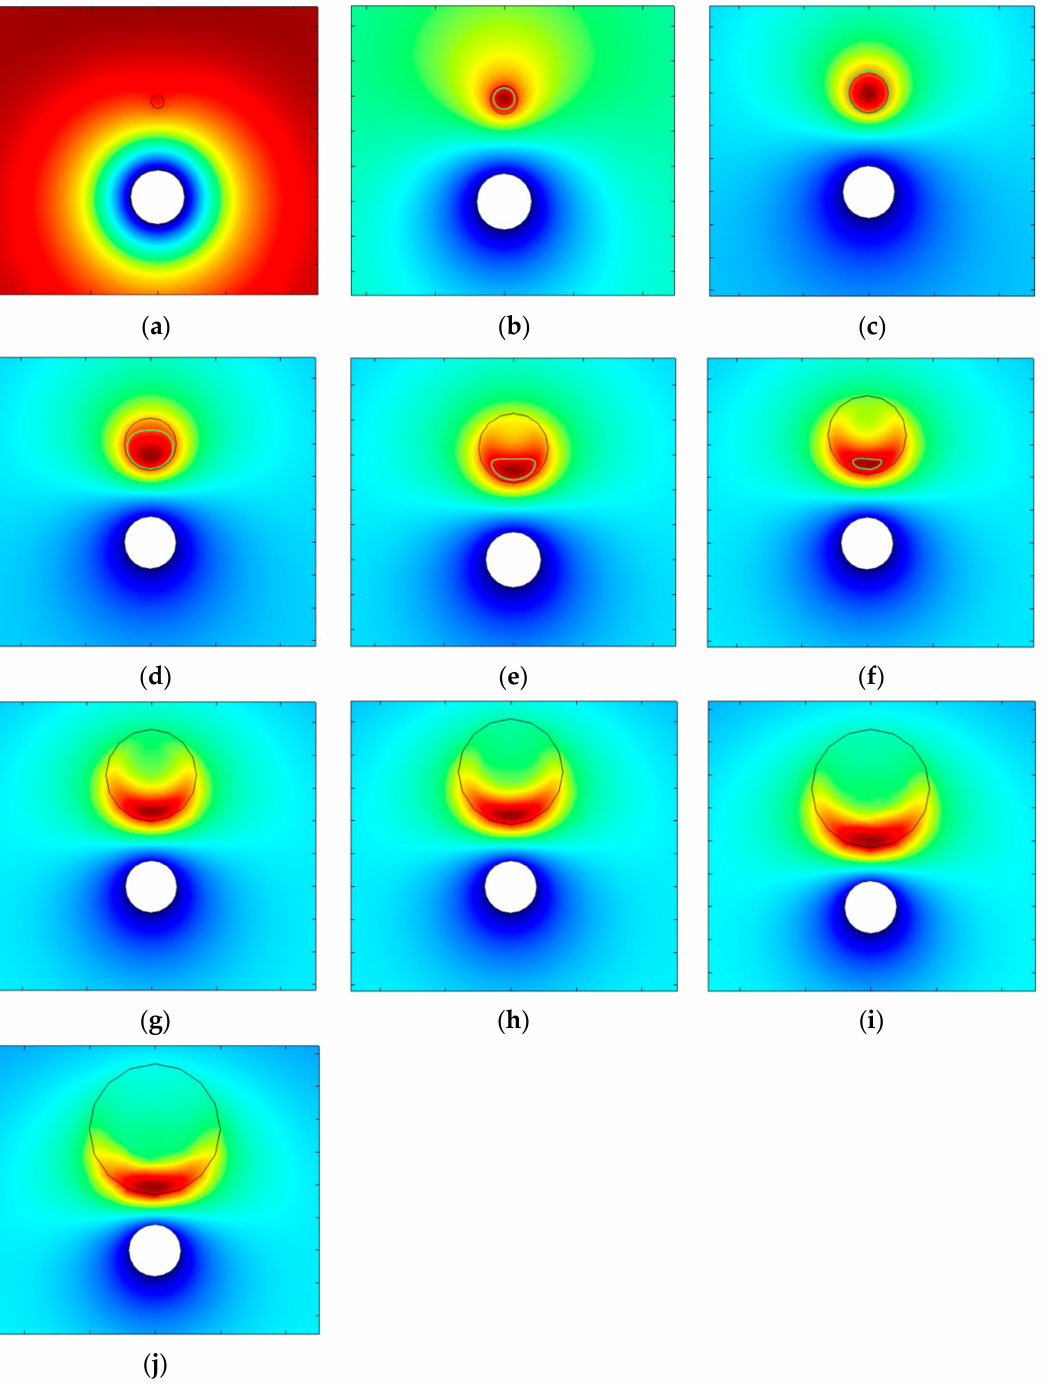
Figure 6. Thermal damage located at the end cross-section of the vessel ( a – j ) indicates vessels with a radius of 0.1–1.0 mm, the green line indicates the range of loss, and the color indicates the temperature (The temperature map transitions from high (red) to low (blue) by color). ( a ) r = 0.1 mm, ( b ) r = 0.2 mm, ( c ) r = 0.3 mm, ( d ) r = 0.4 mm, ( e ) r = 0.5 mm, ( f ) r = 0.6 mm, ( g ) r = 0.7 mm, ( h ) r = 0.8 mm, ( i ) r = 0.9 mm, ( j ) r = 1.0